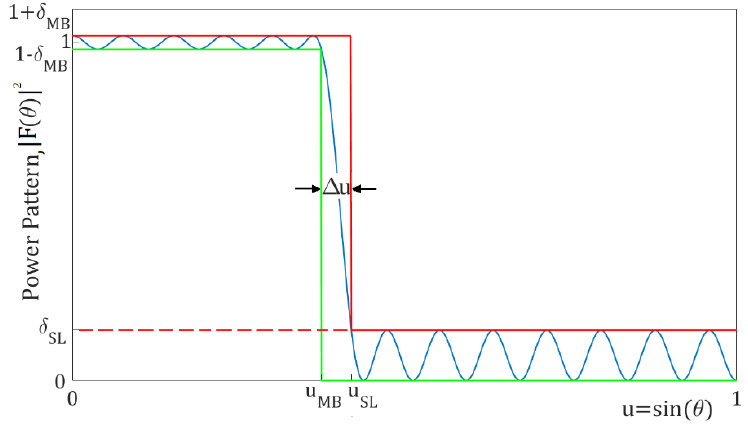
depicted in Figure 1. The additional parameters Δ𝑢 = 𝑢 𝑆𝐿 − 𝑢 𝑀𝐵 and 𝐾 = 𝛿 𝑀𝐵 /𝛿 𝑆𝐿 are also introduced.